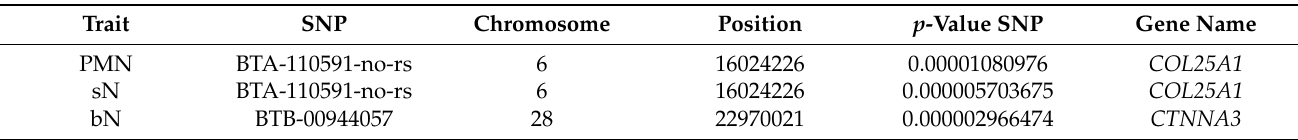
Table 1. Genome-wide significant SNPs for the main effect and potential candidate genes associated with the differential somatic cell fractions.